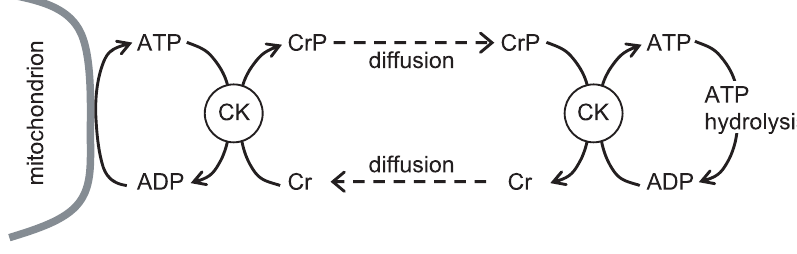
Figure 3. Facilitated diffusion of ATP hydrolysis potential by the creatine kinase system. Phosphocreatine (CrP) is synthesized from ATP near sites of ATP synthesis and diffuses